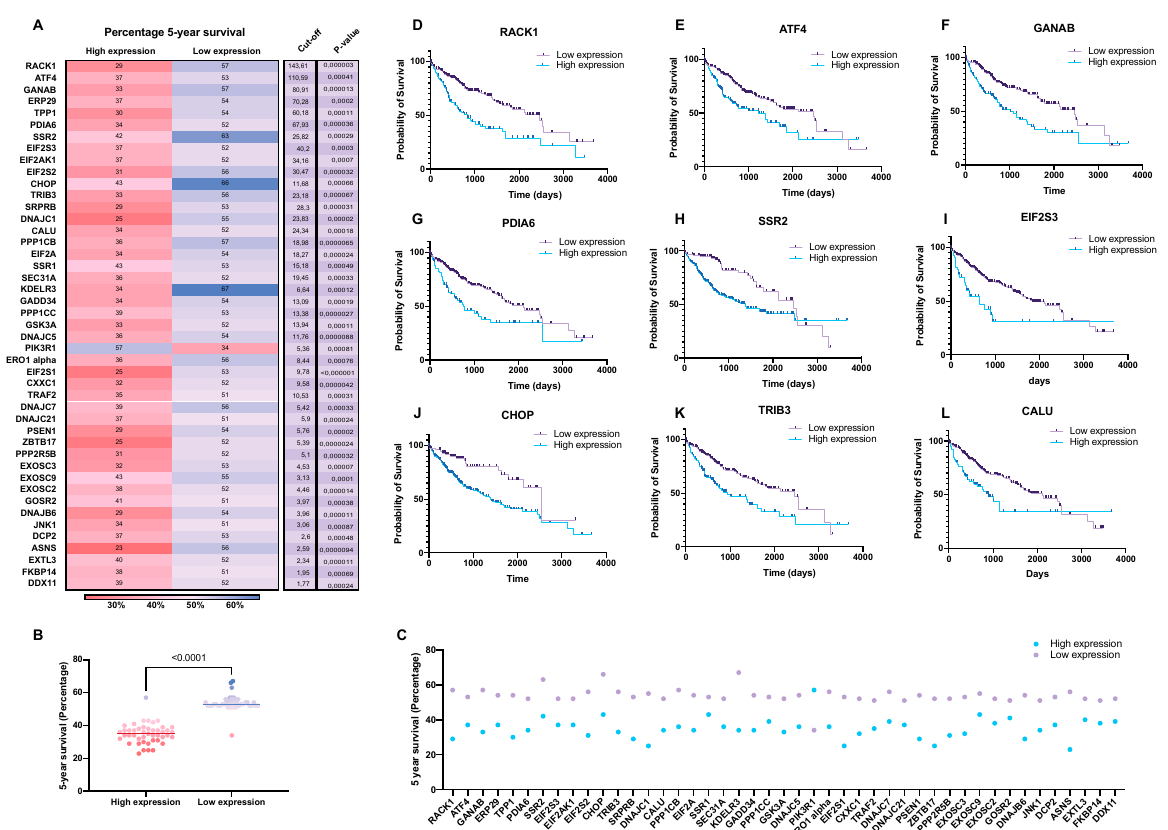
Figure 5. Five-year HCC patient survival data correlated to the expression of unfavorable UPR-associated markers ( A – C ). The selected markers are shown as individual Kaplan–Meier curves ( D – L ) .